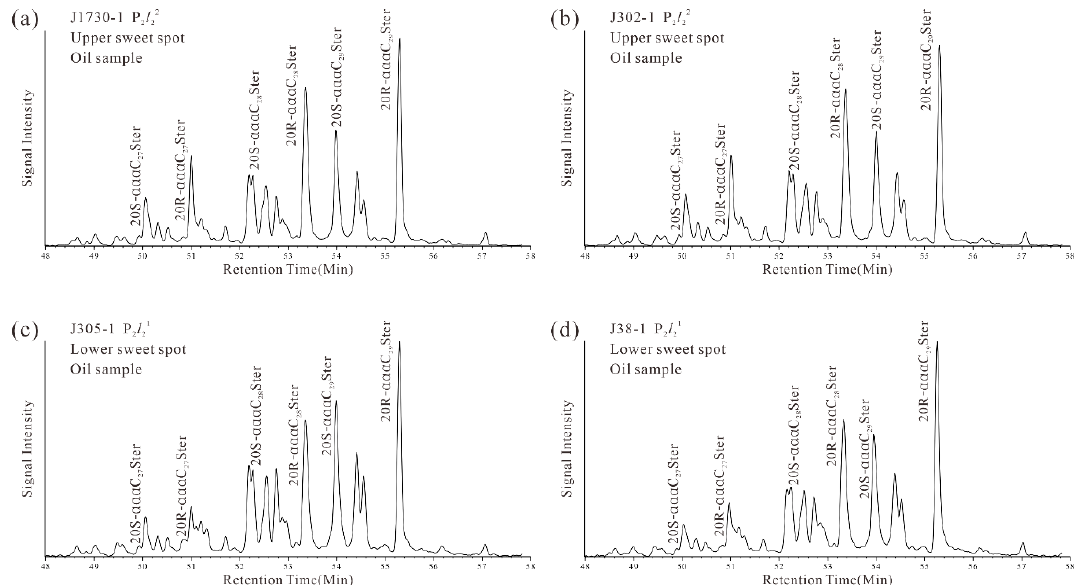
Figure 5. ( a ) Representative mass chromatograms (m/z 191) showing the tricyclic terpanes, tetracyclic terpanes; and ( b ) hopanes of saturated hydrocarbon fraction samples from the upper sweet spot and lower sweet spot.